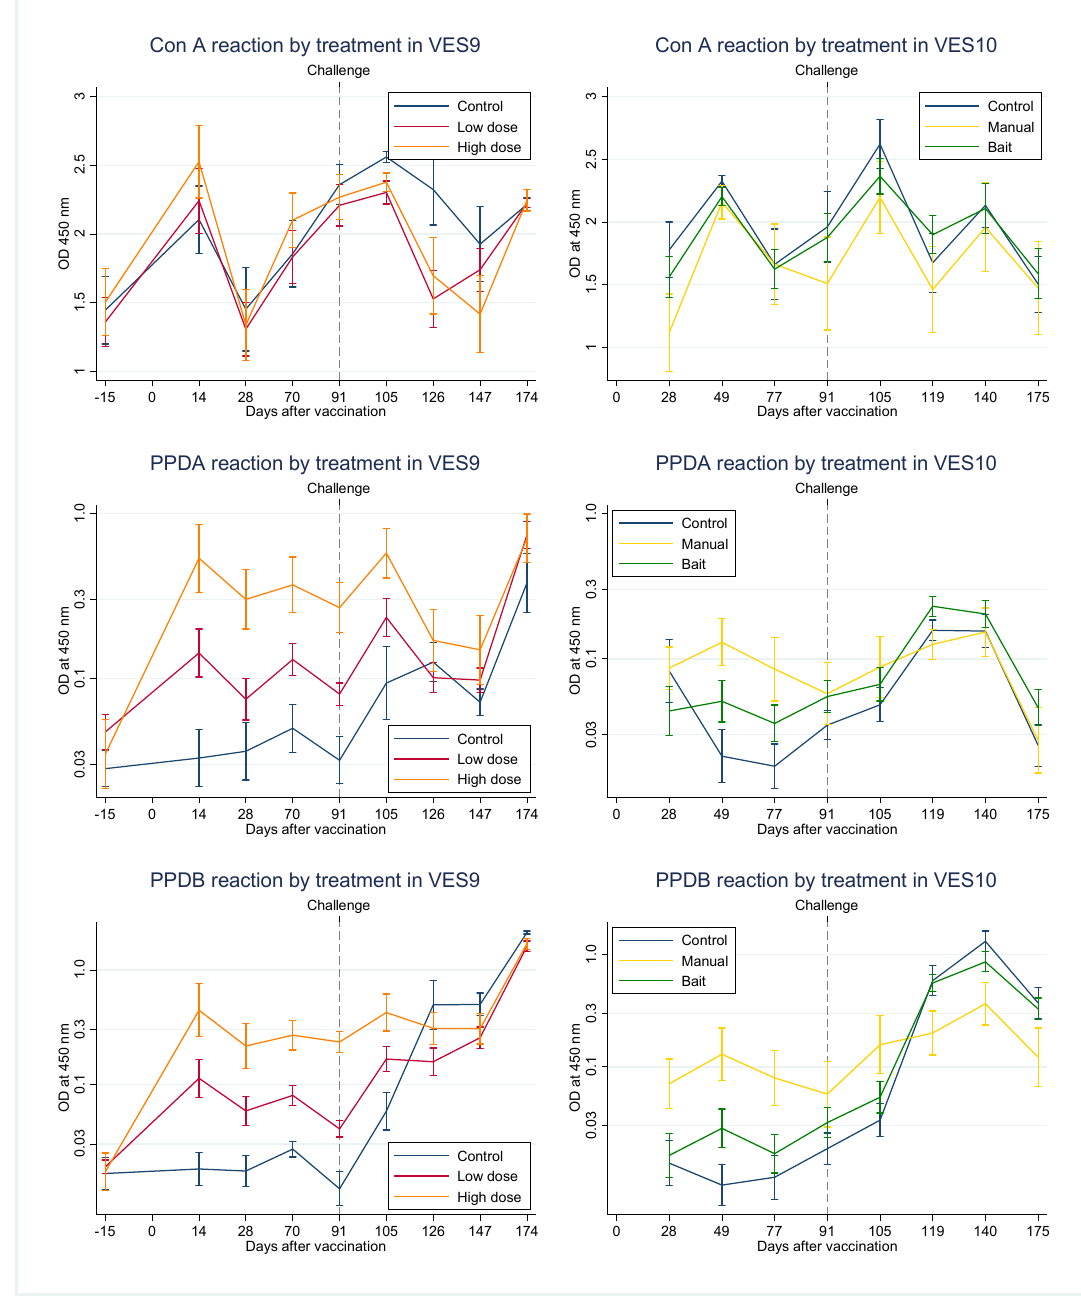
Figure 4. Peripheral blood mononuclear cells (PBMC) interferon-gamma (IFN γ ) enzyme-linked immunosorbent assay (ELISA) (IGRA) for VES9 left and VES10 right, for each of the stimulations shown (ConA = concanavalin A). Error bars are standard errors of the means.